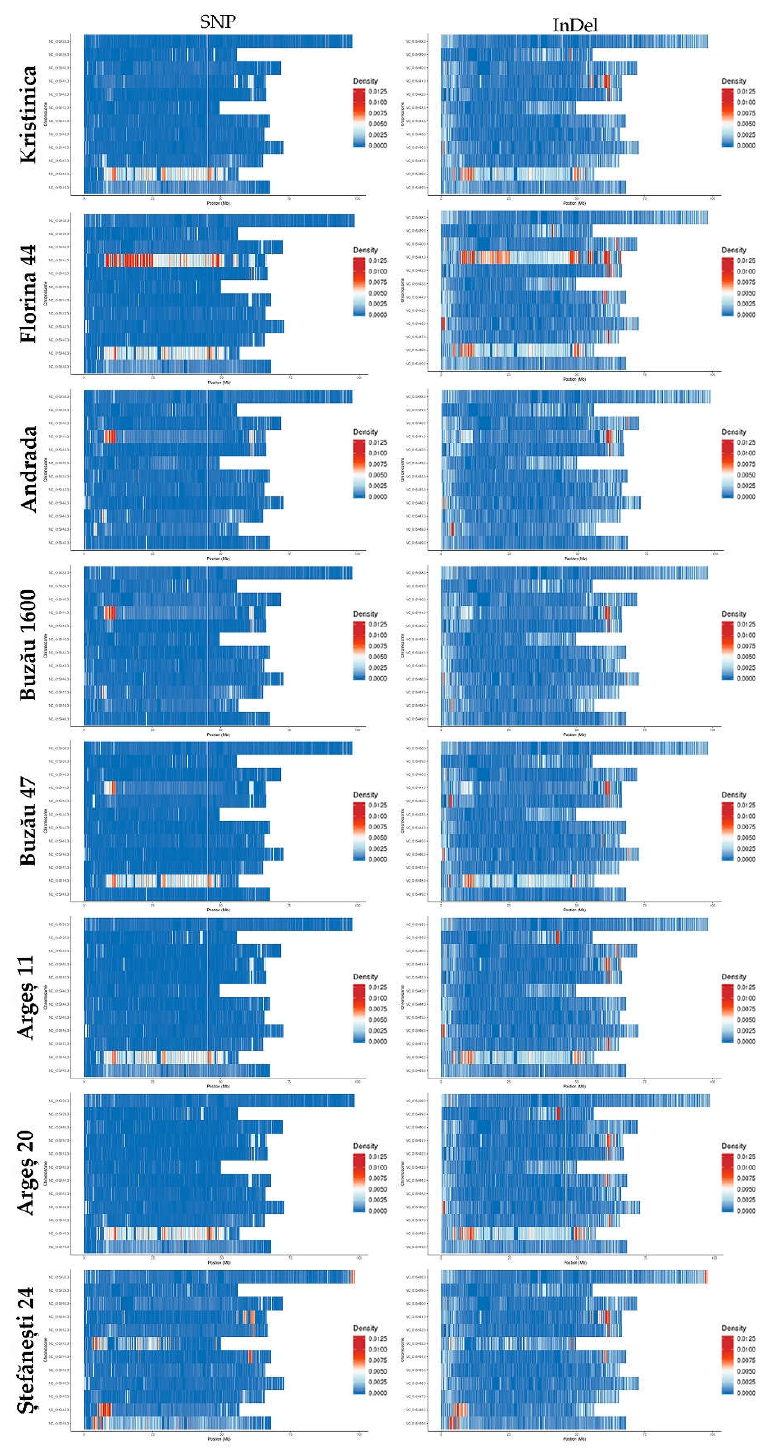
Figure 4. SNP and InDel densities per chromosome per